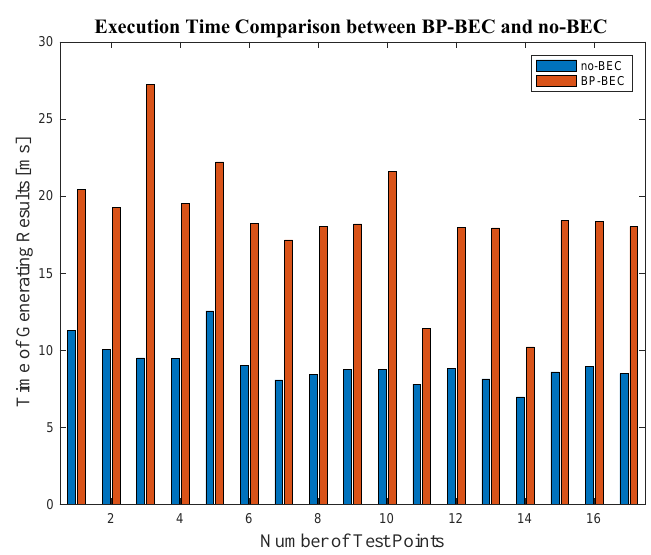
Figure 16. The execution time comparison between the BP-BEC and no-BEC algorithms.